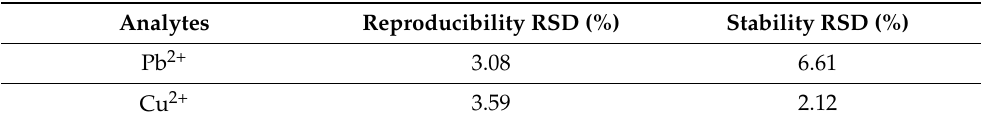
Table 3. Reproducibility and stability of TC4/AuNPs/SPCE for the detection of 1.0 ppm Pb 2+ and Cu 2+ .